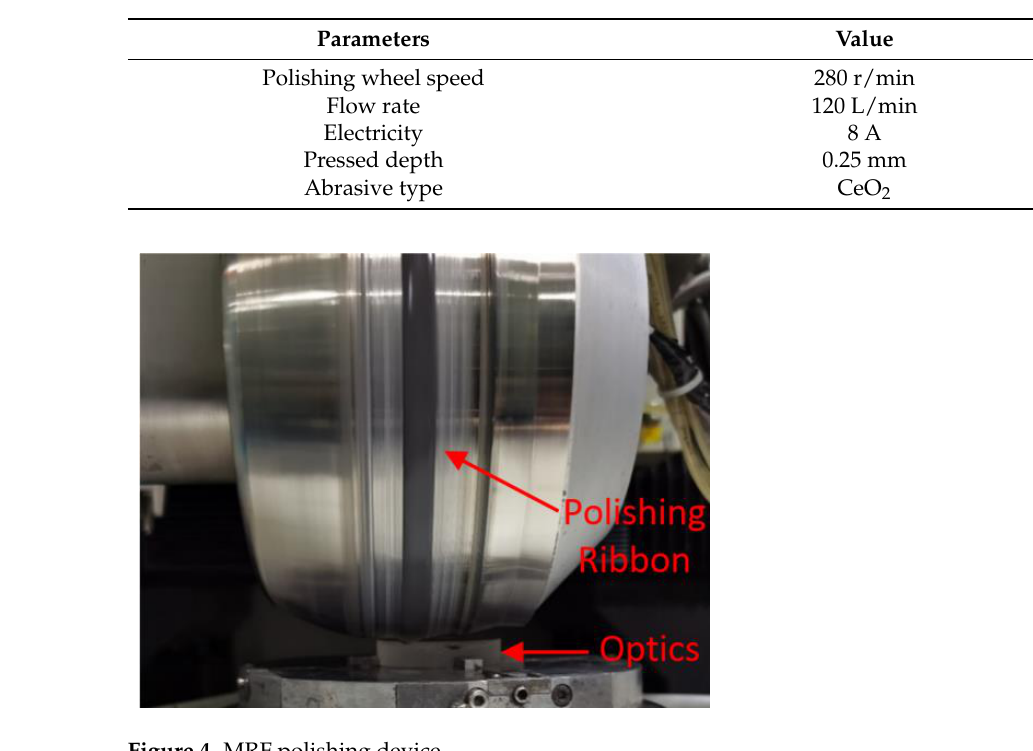
Table 1. Parameters of MRF repair technique.